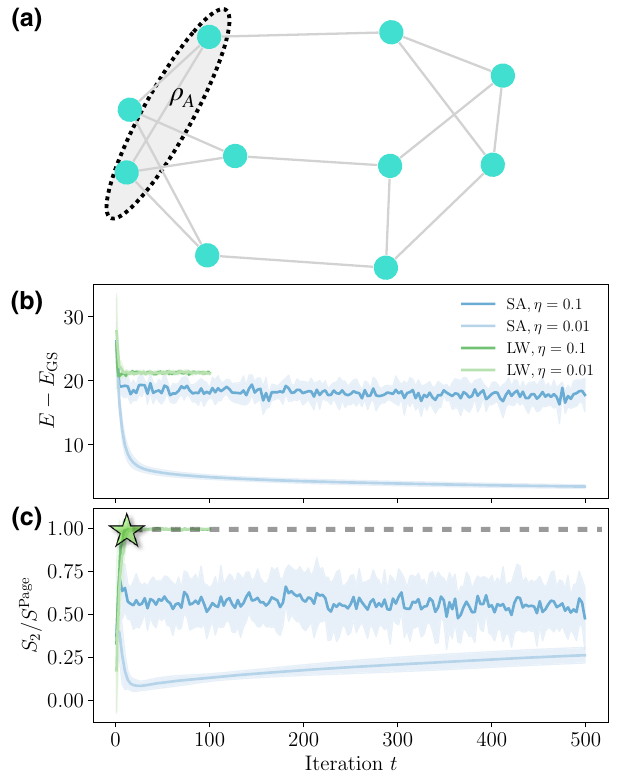
FIG. 6. Application of our algorithm to the problem of find- ing the ground state for the Heisenberg model on a 3-regular random graph depicted in (a). Panel (b) shows the energy as a function of GD iterations t and panel (c) illustrates the second Rényi entropy of two-spin region A with k = 2 shown in panel (a). Since the interactions are now nonlocal and we do not have any prior knowledge on the entanglement properties of the target state we set α = 1 (gray dashed line). For the initialization we use the small-angle initialization (SA) with (cid:11) θ = 0.1 and com- pare it to layerwise optimization (LW). LW encounters a WBP for both learning rates that we consider (green star). In contrast, SA avoids the WBP for both learning rates. Good performance and further convergence in the local minimum is only achieved through a smaller learning rate of η = 0.01. We use a system size of N = 10 and a random circuit from Eq. (1) with circuit depth p = 100. Data is averaged over 100 random